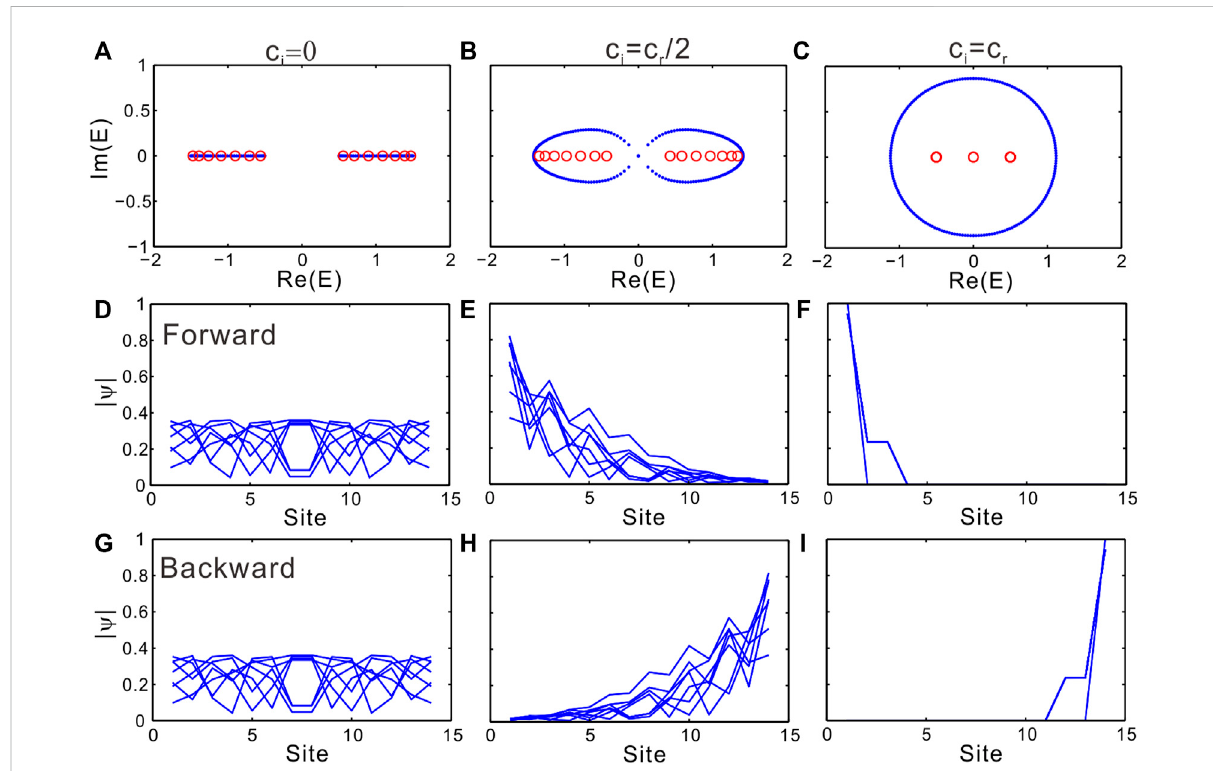
FIGURE 3 NHSEinmodulatedwaveguidearrays. (A – C) Aretheeigenvaluespectraforthreedifferentimaginarycouplingstrengthwith c i =0, c i = c r /2,and c c i = r , respectively. The blue dots and red circles stand for periodic and open boundaries, respectively. (D under OBC for forward propagation. (G – I) Are eigenmode distributions for backward